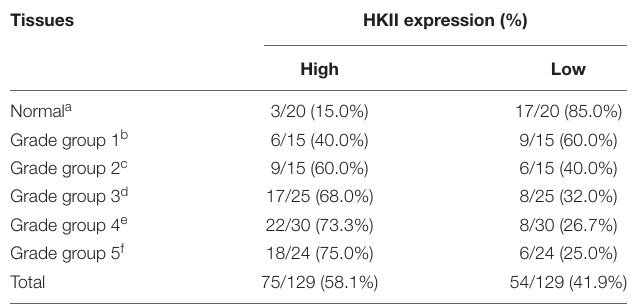
TABLE 2 | Expression of HKII in normal prostate tissues and different grade groups of prostate cancer tissues. Tissues